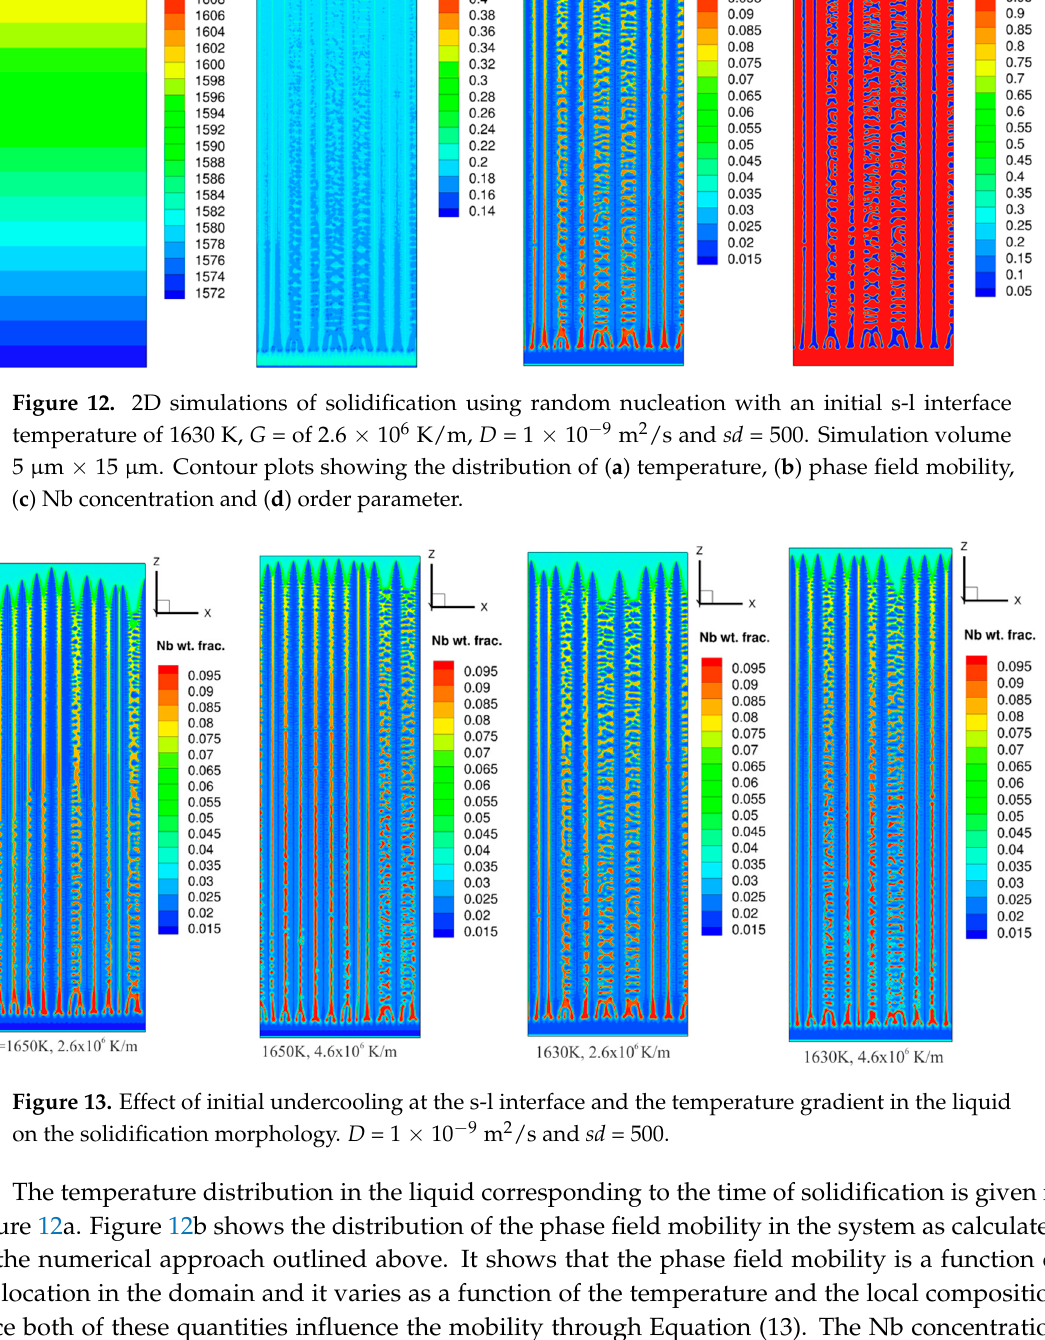
Figure 12. 2D simulations of solidification using random nucleation with an initial s-l interface temperature of 1630 K, G = of 2.6 × 10 6 K/m, D = 1 × 10 − 9 m 2 /s and sd = 500. Simulation volume 5 μ m × 15 μ m. Contour plots showing the distribution of ( a ) temperature, ( b ) phase field mobility, ( c ) Nb concentration and ( d ) order parameter.